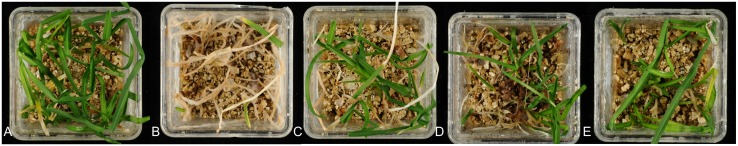
Sterile plantlets of Hemerocallis ‘Jurassic Spider’ inoculated with Botrytis deweyae and Botrytis elliptica isolates.Plantlets were grown in vermiculite with growth medium and are shown from above, 10 days after inoculations. A. B. deweyae B1 isolate. B. B. deweyae B2 isolate. C. B. deweyae B4 isolate. D. B. elliptica. E. control (no fungal inoculation).